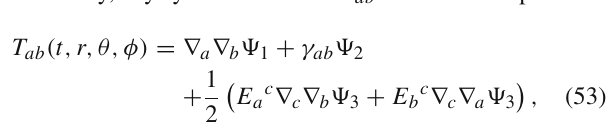
( a ) Free energy of the black hole solution (11) (b) Free energy of the black hole solution (15) Fig. 12 Schematic plot of the free energy and the free energy of the black hole (11)) versus the dimensional parameter α and r + , respectively small w.r.t the background, i.e., g 0 μν >> h μν .